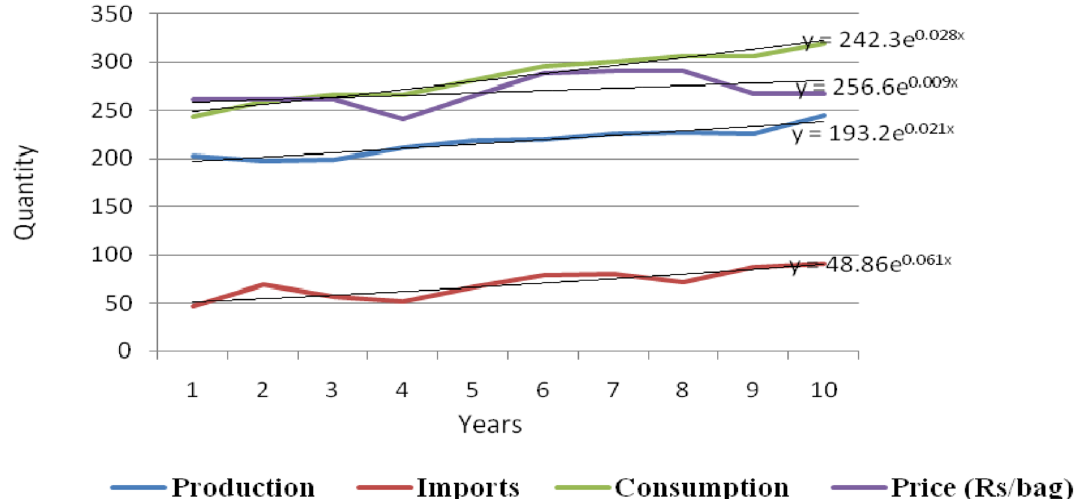
Figure 1. All India urea production, imports, consumption and prices. Source: Authors’ estimates using field survey data. Sl.